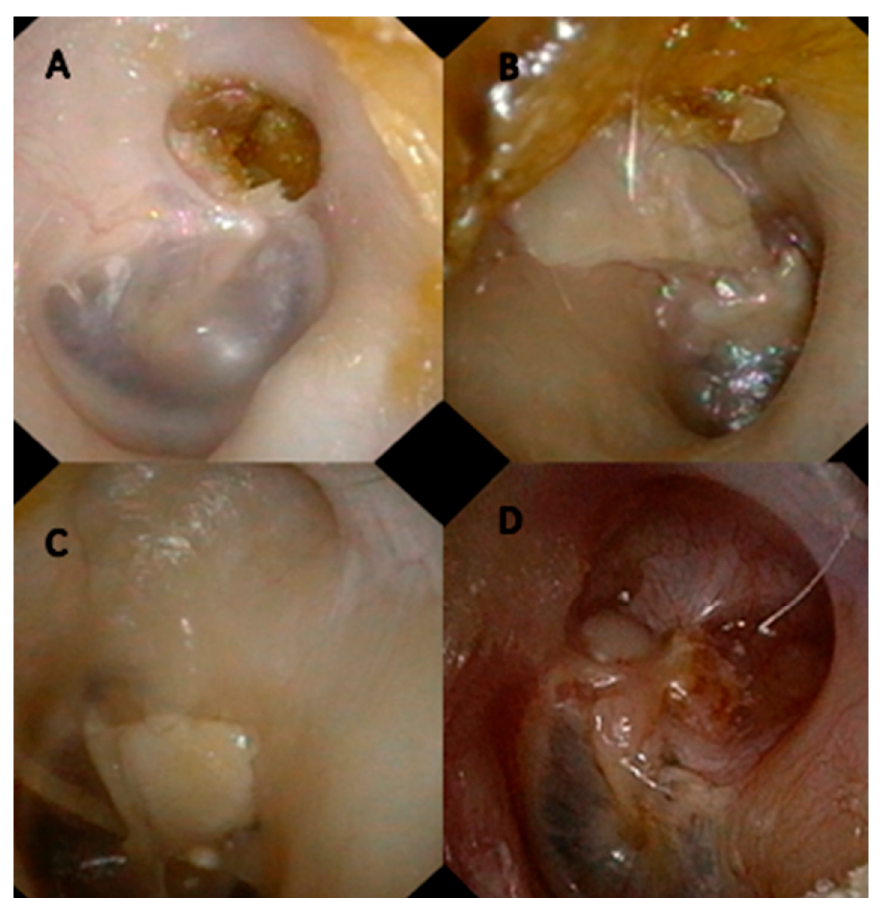
Figure 6. ( A ) Stage II attic cholesteatoma starting to affect the tympanic cavity (this is an ideal case for performing AE-AE). ( B ) Results of AE-AE procedure with cartilage over stapes. ( C ) Results of AE-AE procedure with cartilage over TORP. ( D ) Results of AE-AE procedure without ossiculo-plasty.